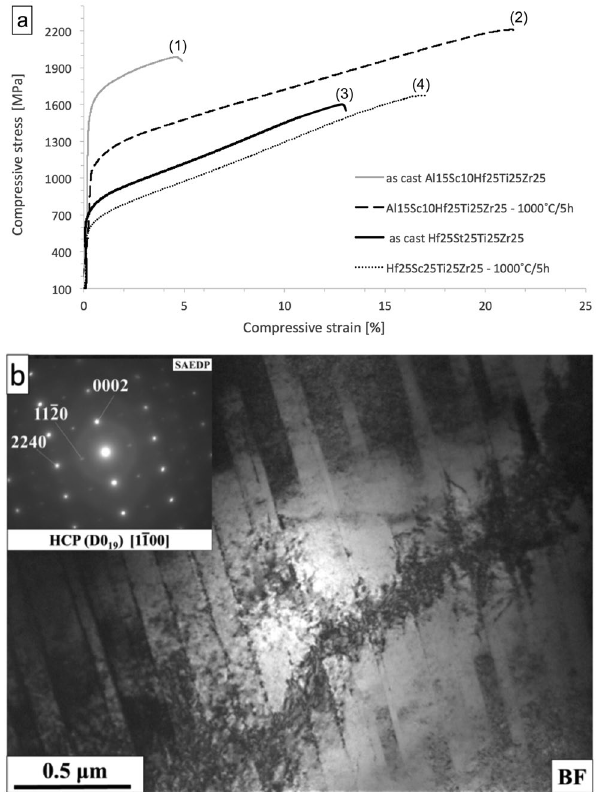
Figure 9. ( a ) Compression curves of the Al 15 Hf 25 Sc 10 Ti 25 Zr 25 at.% alloy in the as cast state (curve 1) and annealed state at 1000 °C for 5 h (curve 2), and of Hf 25 Sc 25 Ti 25 Zr 25 at.% in the as cast (curve 3) and annealed (curve 4) state. ( b ) TEM bright field image with SAED pattern of the annealed Al 15 Hf 25 Sc 10 Ti 25 Zr 25 at.% HEA after compression to 22%